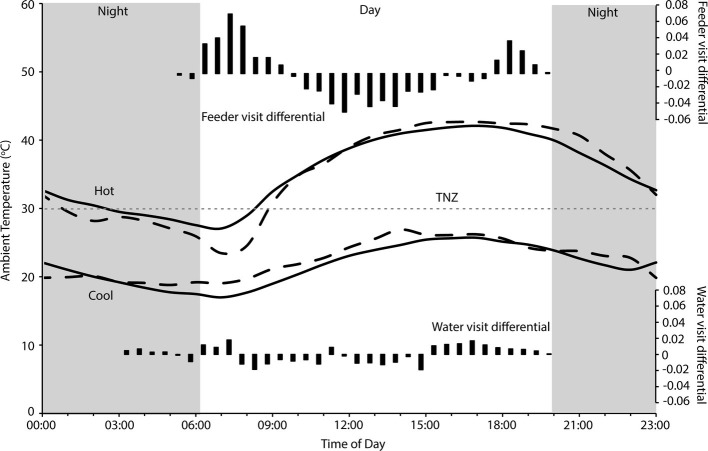
Hourly temperature during hot and cool periods at Fowlers Gap research station, when visits to feeders and water troughs by zebra finches (Taeniopygia guttata) were monitored (solid lines), and when FMR and WTR were measured (dashed lines). The gray dashed line indicates thermoneutrality (TNZ; 30°C) for zebra finches (Calder, 1964; Cade et al., 1965) and the gray panels indicate the period from sunset to sunrise. Black bars indicate the differential of frequencies (from Figure 1) of visits on hot to cool days, standardized to total number of hot day visits, to four feeders (top panel) and two water tanks (bottom panel). Temperature data sourced from the Australian Bureau of Meteorology for Fowlers Gap (station number 046128).